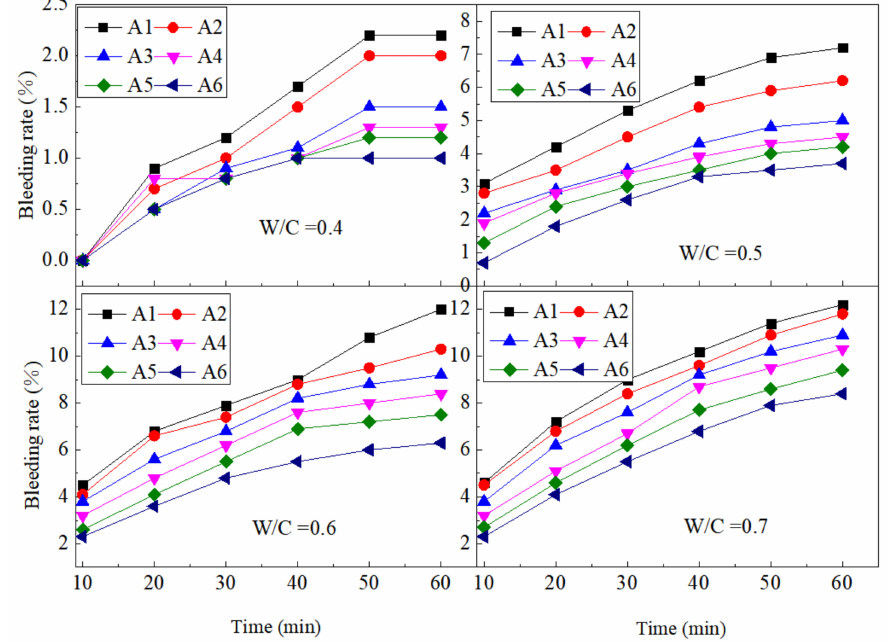
Figure 5. Variations of bleeding rate with w/c at different SF substitute